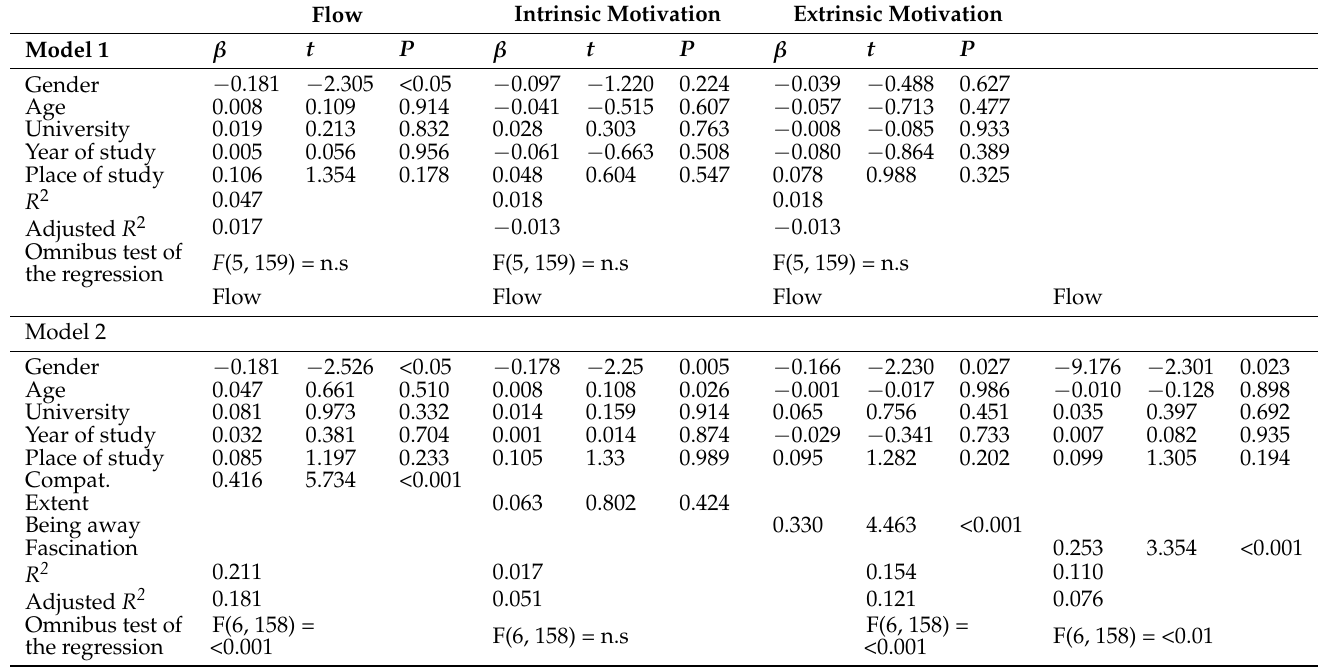
Table 2. Hierarchical Regression Analyses of the Independent and Interactive Associations of Socio-Demographic and contextual variables, and Sub-Dimension of Perceived Restorativeness (Compatibility, Extent, Being Away, Fascination) with Flow, and Intrinsic and Extrinsic Motivation (N =